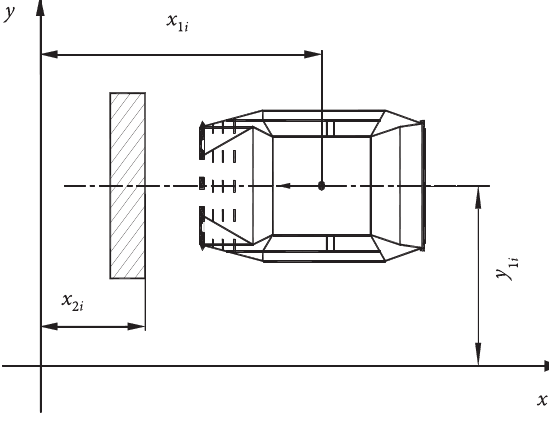
Fig. 10. Scheme of collision with an immovable fl at